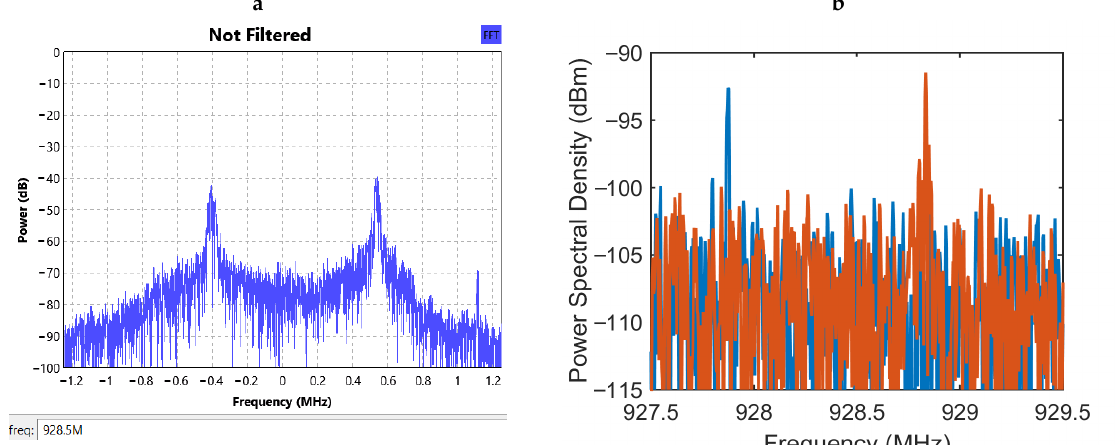
Figure 9. ( a ) Relative power spectral density at the front end of the SDR receiver. ( b ) Two superposed plots of power spectral density measurements recorded with a real-time spectrum analyzer to obtain the absolute levels of the received